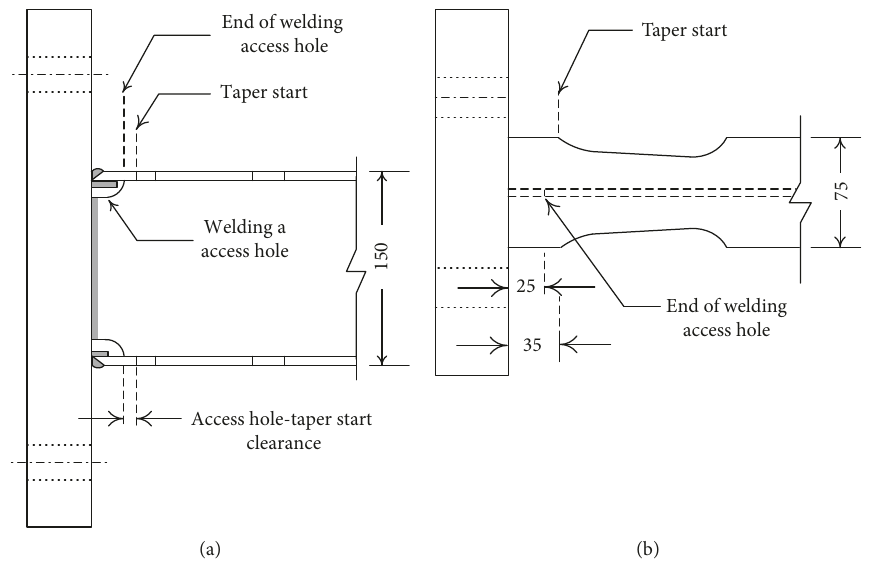
Figure 22: Access hole-taper start clearance of WBC. (a) Elevation view. (b) Top view.